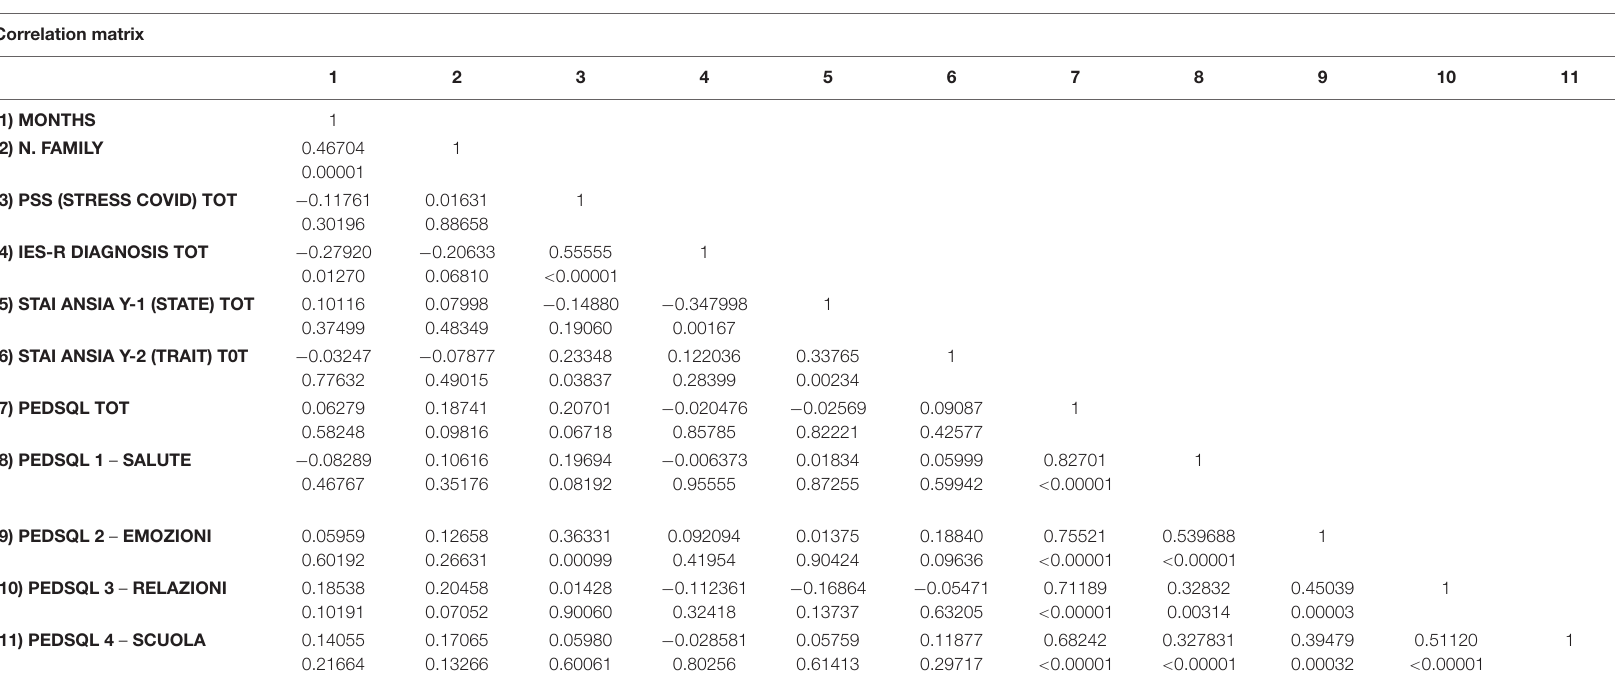
TABLE 2 | Cross correlation matrix coefficients (up) and Pearson correlation tests P -Values (down) in each item of the table. Correlation